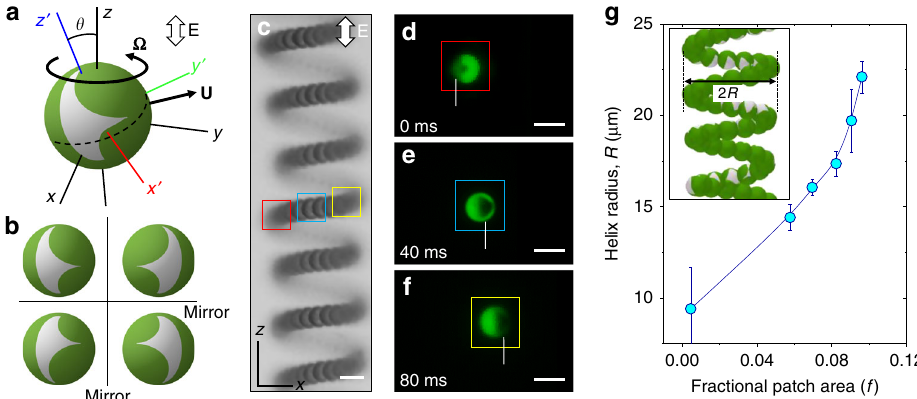
Fig. 4 Patch orientation and effect of its size on helical motion. a Schematic showing the reference frames and velocity (angular and linear) vectors of a particle aligned at an oblique angle ( θ ) with the axis of the applied fi eld ( z -axis). b Schematics of the four degenerate states of a particle with a triangular patch in uniform AC-electric fi eld. The four stable orientations result in the four distinct helical trajectories of the particle. c Superimposed bright- fi eld micrographs of a patchy particle migrating along cylindrical helical trajectory in an AC-electric fi eld of strength 250 V cm − 1 and frequency 10 kHz. d – f Fluorescence micrographs of the particle with a triangular metal patch performing helical motion. Here the color of the boxes corresponds to the location of the particle along its helical path as shown in c (Supplementary Movie 3). Scale bars shown in c – f are 5 µ m. g Increase in the radius of the helical trajectory with increasing size of the triangular metal patch at constant electric fi eld of 325 V cm − 1 and frequency 10 kHz and particle radius a = 2.6 μ m. The error bars in g refer to the standard deviation of the data set of at least ten measurements